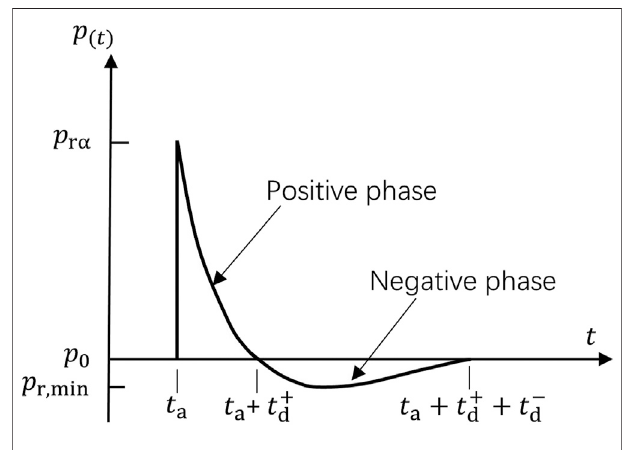
FIGURE 2 | Pressure-time history.